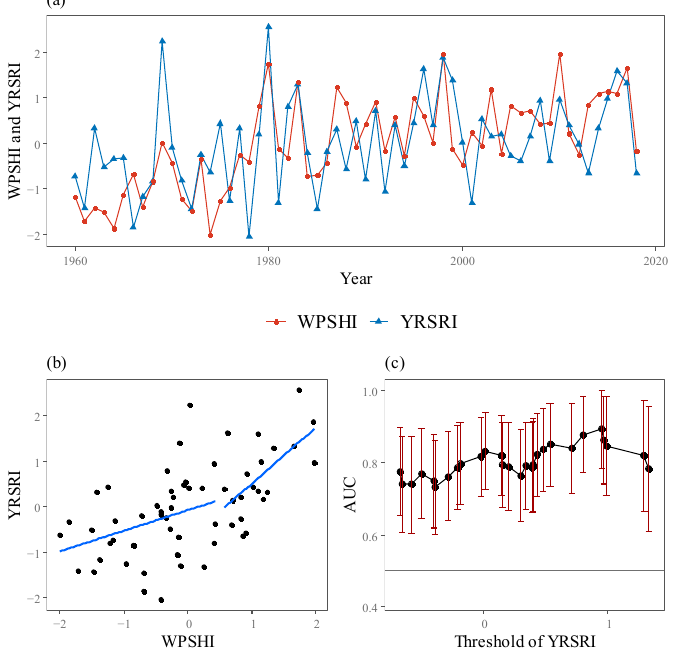
Figure 5. ( a ) Time series of the YRSRI and WPSHI (R), and ( b ) the scatter plot of these two variables. ( c ) The AUC values and their 95% confidence intervals corresponding to different thresholds of YRSRI.